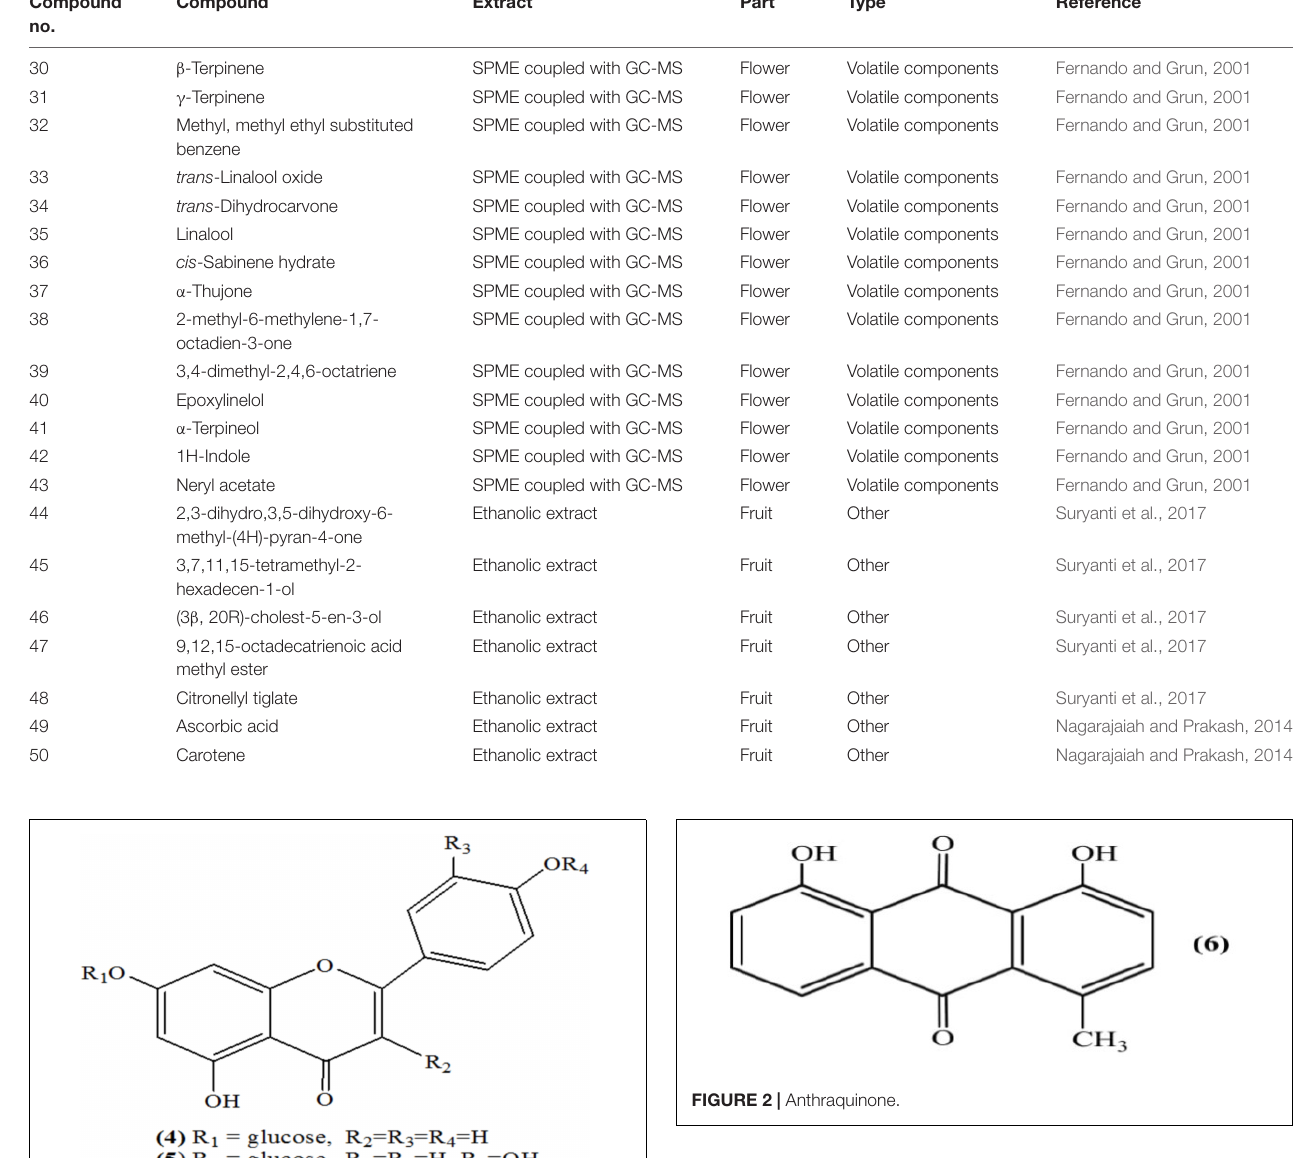
Investigational analysis of seed oil showed the presence of total saturated (32.1%) and unsaturated (67.9%) fatty acids which were recognized as myristic (0.45%) (7) , palmitic (20.9%) (8) , stearic (10.8%) (9) , oleic (24.1%) (10) , and linoleic (43.7%) acid (11) ( Figure 3 ). Iodine value, saponification value and acid value of the seed oil were found to be 99.5, 190.8, and 10.5, respectively. The minerals like Fe, Ca, Zn, Cu, P, and Mg were also identified from the seed kernel (Kamel and Blackman, 1982).